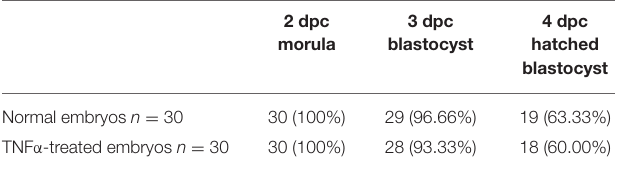
TABLE 3 | The developmental rate of morulae obtained at 2 dpc after completed cultivation of embryos in the presence or absence of TNF α . Compacted morulae were selected, washed 10 times, and transferred to a fresh culture medium and then examined on three consecutive days ( χ 2 test p ≥ 0.05). 2 dpc